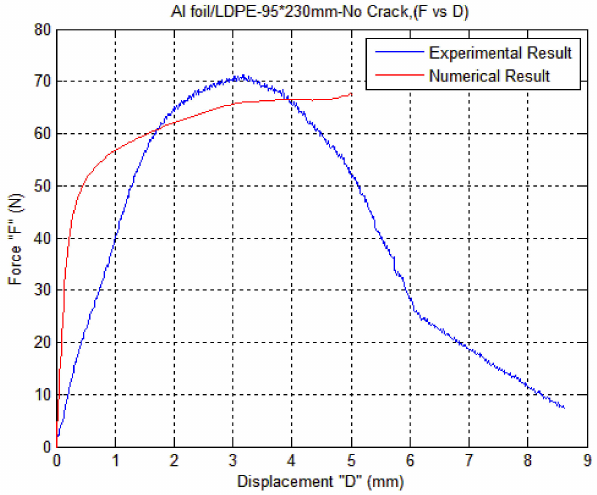
Figure 16. Force vs. displacement of aluminum foil/LDPE without crack.